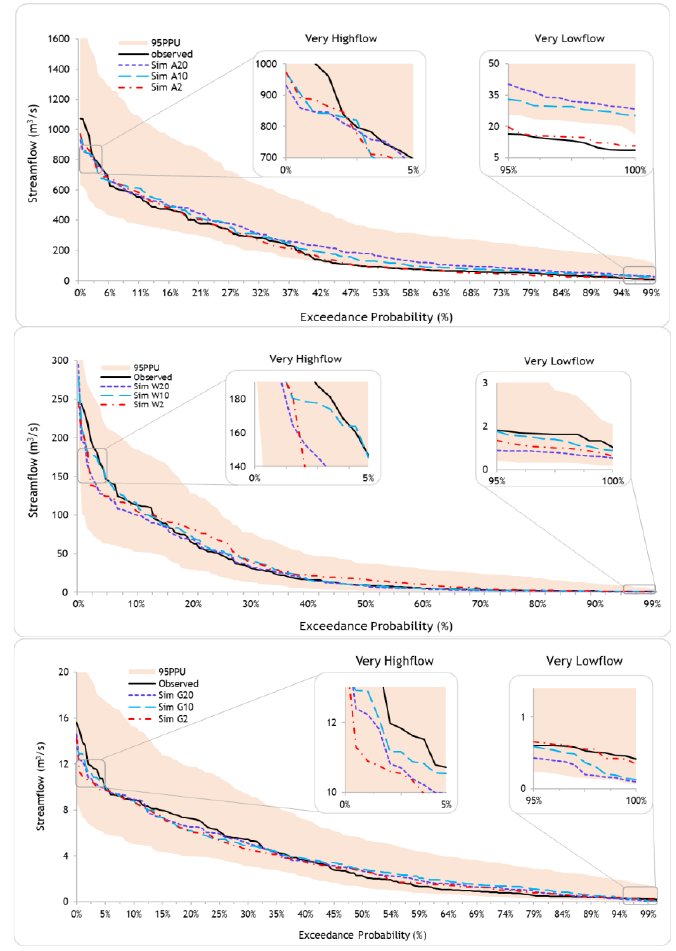
Figure 11. Observed and best-simulated flow for the two extreme (0–5 and 95–100%) flow phases based on the 95PPU plot and several subbasin spatial scales of the Abelti, Wabi, and Gecha catchments (top-to-down, respectively). (Note that A = Abelti, G = Gecha, and W = Wabi together with their 2, 10, and 20 as percentages of the total area to obtain different subbasin numbers). Figure 12 depicts the improvements in RMSE for modeling the various flow phases in the analyzed watersheds over the periods of calibration and validation. The calibration phase had average RMSE advancements of 58%, 68%, and 63%, whereas its validation period showed average RMSE improvements of 56%, 71%, and 63%, respectively, at the Abelti, Gecha, and Wabi catchments’ different flow phases by using an appropriate sub- basin geographic level.